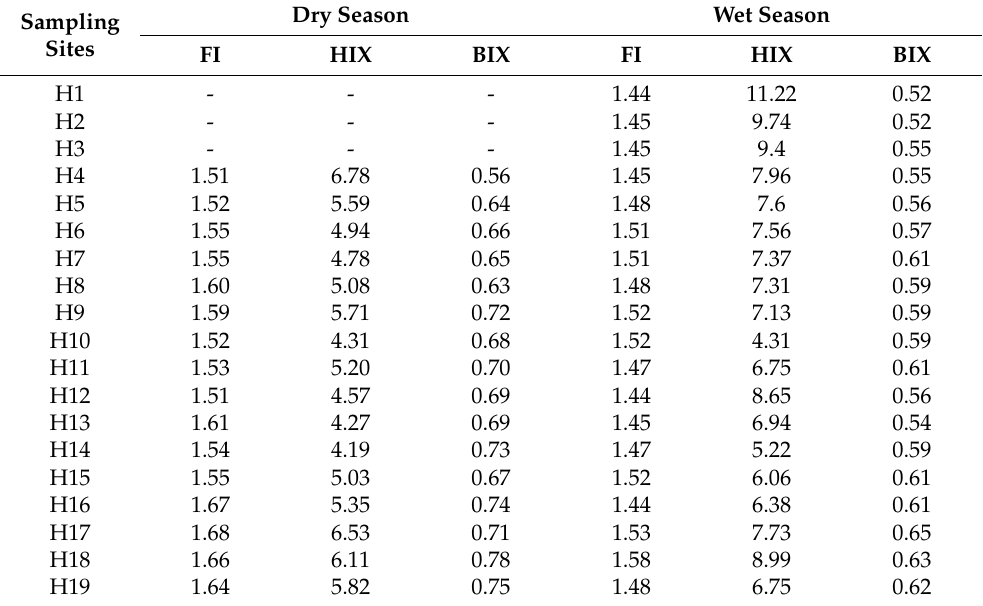
Table 2. Fluorescence indices of DOM during the dry and wet seasons.